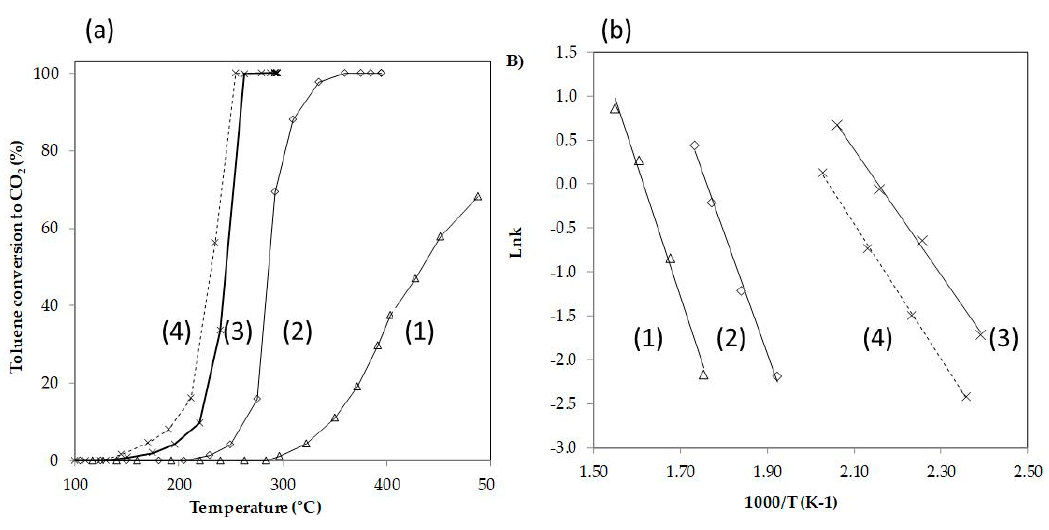
Figure 11. ( a ) Catalytic performance and ( b ) Arrhenius plots of the DBM-based catalysts ((1) DBM[toluene] in = 400 ppm, (2) Ag / DBM[toluene] in = 400 ppm, (3) Mn / DBM [toluene] in = 400 ppm, and (4) Mn / DBM [toluene] in = 130 ppm). Table 3. Catalytic performance of di ff erent catalysts for the oxidation of